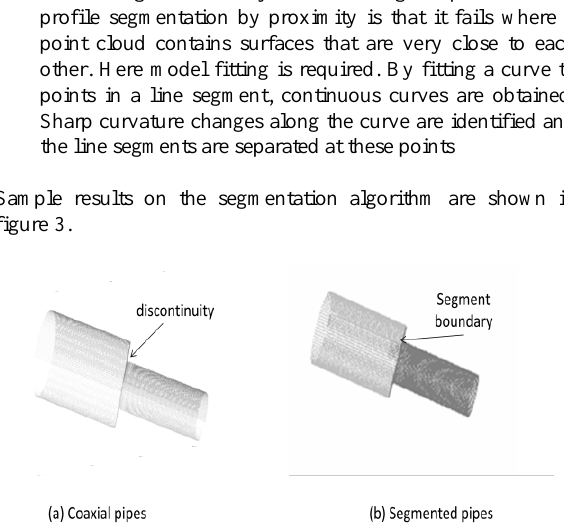
Figure 4. Each geometric primitive above can be described by a radius and axis. Intersecting the primitives with a plane results Figure 3. Sample 2: Segmentation of pipes by curve fitting- in ellipses. The properties of the ellipses formed are described segmentation of coaxial pipes (a) Pipes before segmentation and in section 4.1 (b) after segmentation The results of the segmentation are individual point clusters representing piping elements. These elements have to be identified (i.e. tori, cylinder, sphere, and cone). This is done through the detection procedure detailed in the next section.